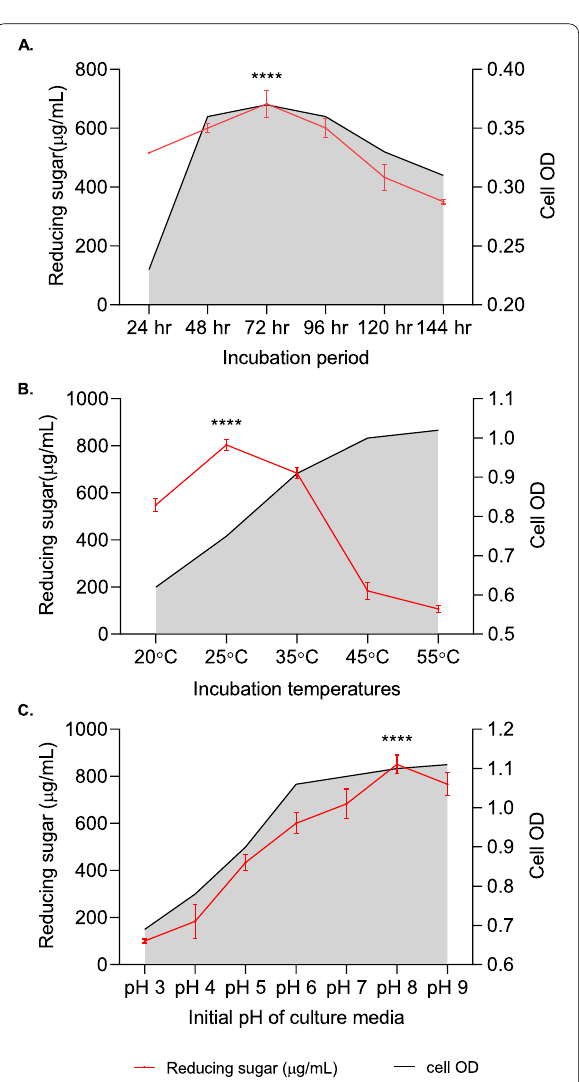
Fig. 2 Effect of A incubation period, B temperature, and C initial pH of culture media on the production of reducing sugar by Arthrobacter woluwensis TDS9. Cell OD was measured at 600nm wavelength. Upon optimization, each culture parameter was kept constant in the following steps. **** indicates statistical significance value, P <